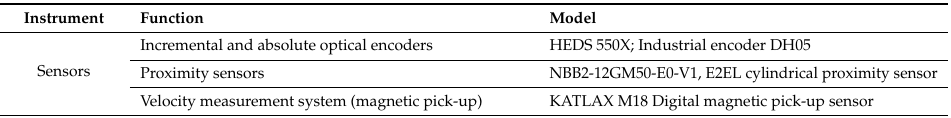
Table 1. Sensors, actuators and computing and control equipment. CSIC, Consejo Superior de Investigaciones Cient í